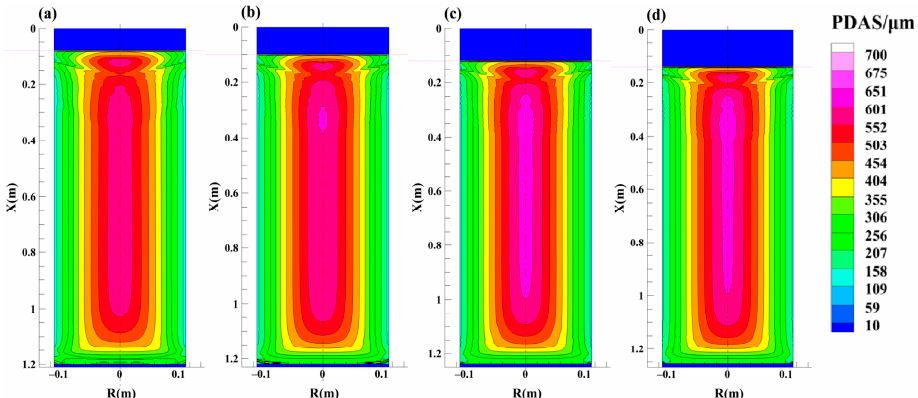
Figure A7. Distribution of PDAS with varying slag thickness: ( a ) 0.08 m, ( b ) 0.10 m, ( c ) 0.12 m and